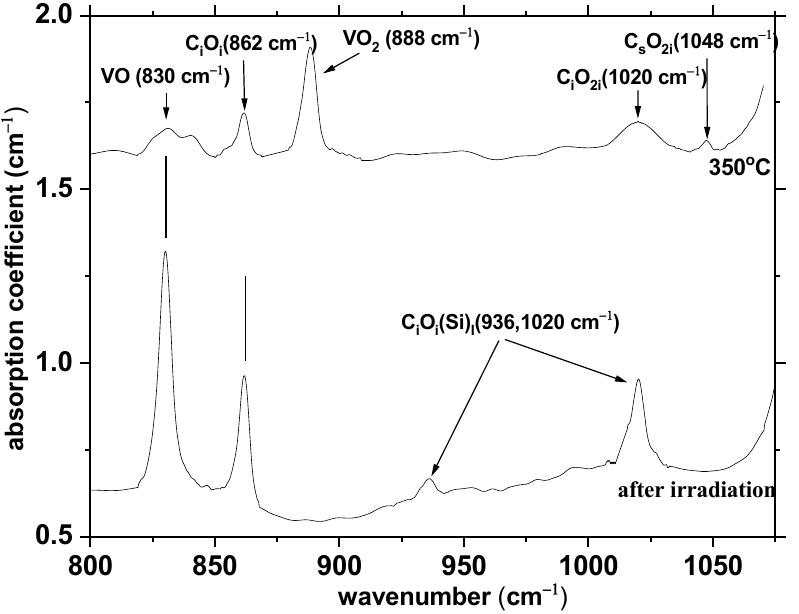
Figure 1. Segments of IR spectra of electron irradiated Si samples immediately after irradiation and at the characteristic T of 350 °C during the isochronal anneal sequence.